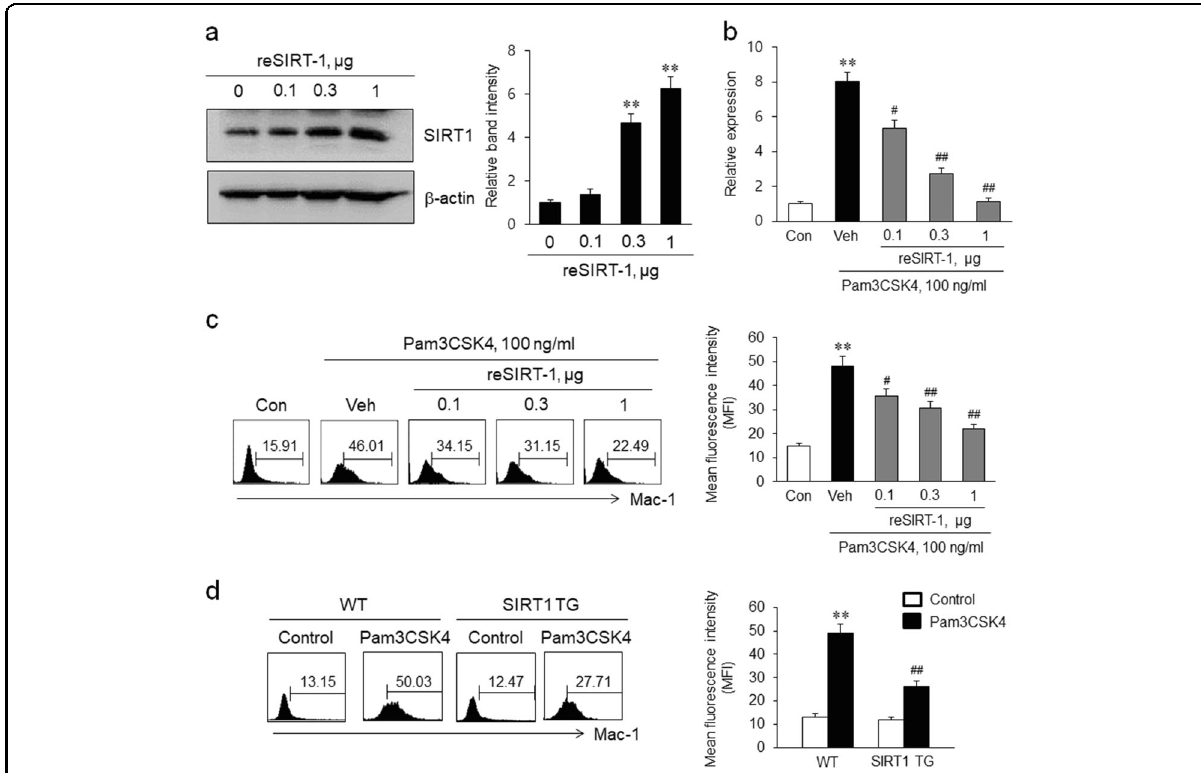
Fig. 2 The effects of SIRT1 on TLR2-induced Mac-1 expression in monocytes. a THP-1 cells were treated with the indicated concentrations of recombinant SIRT1 (reSIRT1) for 24 h, and cellular SIRT1 levels were determined using Western blotting. Quantitative data are presented as the means ± SEM of four independent experiments. **P < 0.01 compared with the control. b , c THP-1 cells were pretreated with the indicated concentrations of reSIRT1 for 30 min and then stimulated with 100 ng/mL Pam3CSK4. The levels of Mac-1 mRNA and protein were analyzed using real-time PCR and fl ow cytometry, respectively. Quantitative data are presented as the means ± SEM of 5 – 7 independent experiments. **P < 0.01 compared with the control (Con); # P < 0.05 and ## P < 0.01 compared with the vehicle (Veh). d Representative images of fl ow-cytometry plots of Mac-1 expression in PBMCs isolated from WT and SIRT1 TG mice treated with 1 mg/kg Pam3CSK4 for 24 h. Levels of Mac-1 protein was analyzed using fl ow cytometry, and mean fl uorescent intensities (MFI) were quanti fi ed and the data are presented as the means ± SEM of six independent experiments. **P <